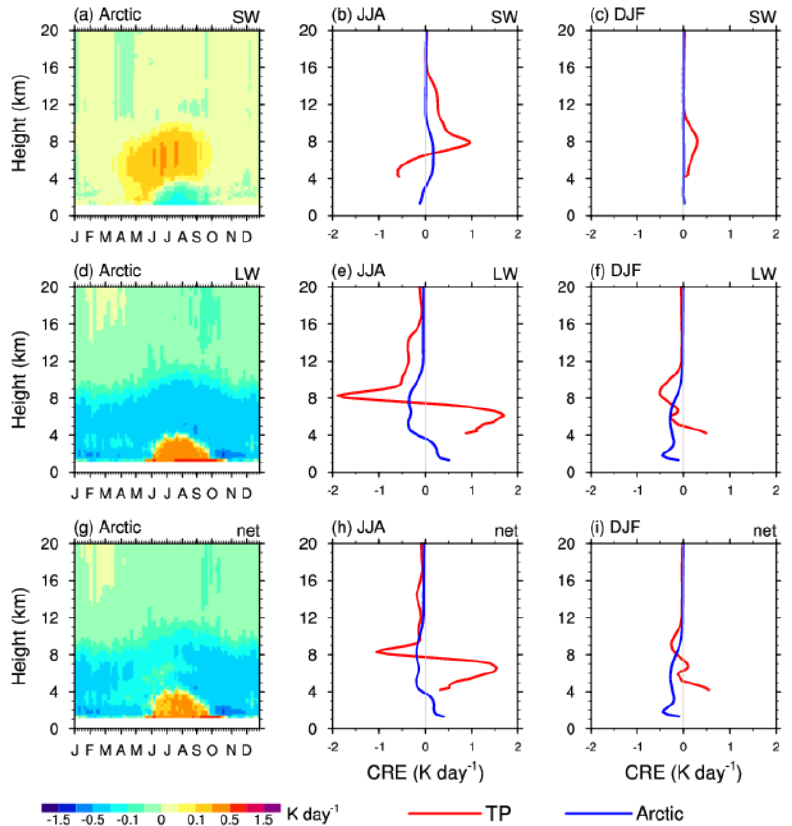
Figure 3. Seasonal cycle of the vertical profile of the cloud radiation effects (CRE) per unit mass over ( a , d , g ) the Arctic and a comparison of the vertical profile of CRE per unit mass over the Arctic (blue) and the TP ( red ) in ( b , e , h ) boreal summer and ( c , f , i ) boreal winter for the ( a – c ) shortwave (SW), ( d – f ) longwave (LW), and ( g – i ) net (SW+LW) CRE. The grey lines in the center and right panels represent 0 K day − 1 .